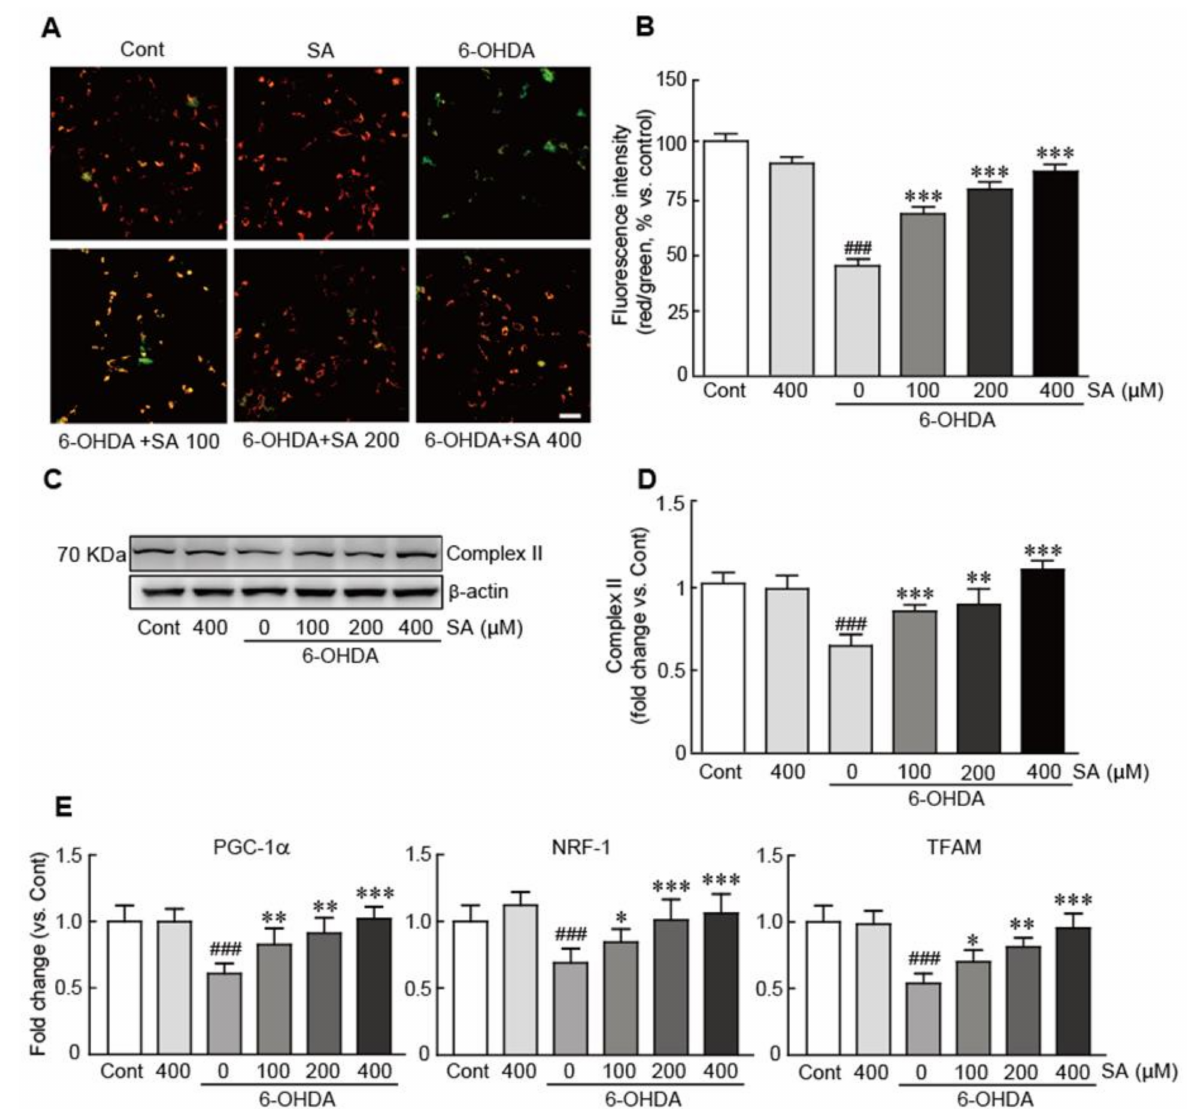
Figure 5. SA suppresses mitochondrial dysfunction caused by 6-OHDA-induced neurotoxicity in SH-SY5Y neuroblastoma cells. Representative photograph of the JC-1 staining assay ( A ) and red and green fluorescence intensities ( B ) in cells treated with 6-OHDA for 24 h with or without 100, 200, and 400 µ M SA pretreatment for 24 h. ( C ) Western blot analyses were performed to measure the expression of mitochondrial complex II protein in SA-pretreated/6-OHDA-treated cells. ( D ) The expression level of mitochondrial complex II protein was quantified using HD imaging software. β -actin was used as the loading control. ( E ) qRT-PCR analysis was performed to determine the mRNA expression levels of the mitochondrial biogenesis genes PGC-1 α , NRF-1, and TFAM. Western blot and qRT-PCR analysis were performed in triplicate with three independent samples. All data are reported as the mean ± standard error of the mean (SEM). Significance was determined via a one-way ANOVA coupled with Bonferroni’s post hoc test. ### p < 0.001 vs. control group. * p < 0.05, ** p < 0.01, and *** p < 0.001 vs. 6-OHDA-only-treated group. Cont, control; SA, sinapic acid; 6-OHDA, 6-hydroxydopamine; Complex II, mitochondrial complex II protein; PGC-1 α , peroxisome proliferator-activated receptor- γ coactivator-1 α ; NRF-1, nuclear respiratory factor-1; TFAM, mitochondrial transcription factor A. Scale bar, 100 µ